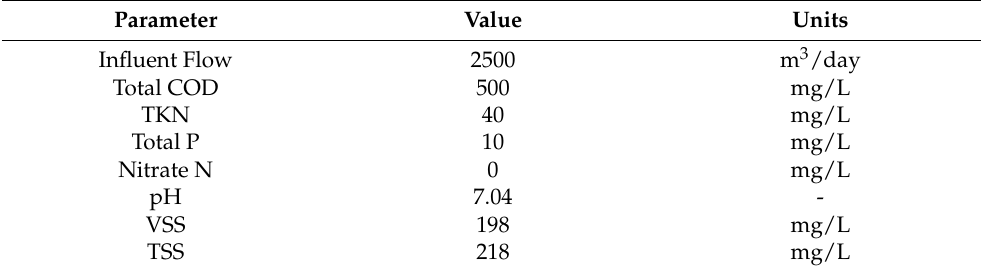
Figure 1. Process flow diagram of the MBR-MD hybrid system. Table 1. Characteristics of the medium-strength municipal wastewater [32] used as the influent wastewater for the MBR-MD and Baseline system